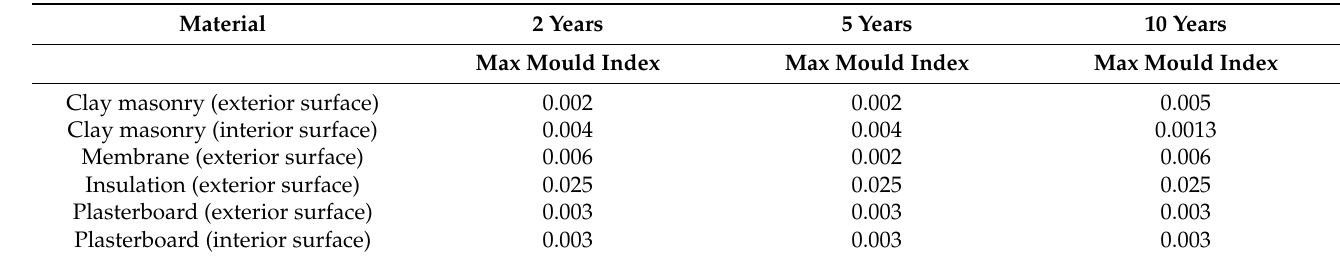
Table 11. Mould growth simulation results for the 7-star clay masonry veneer wall—northern orientation.